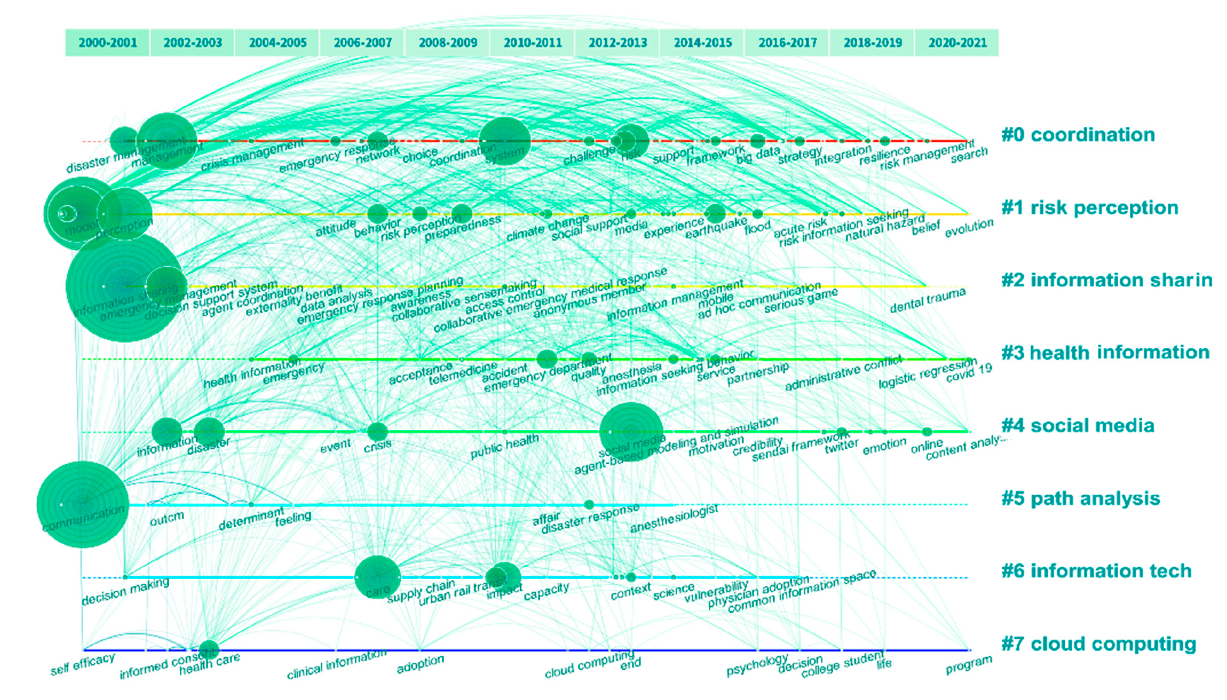
Figure 7. Keyword timeline view of publications on information communication in disasters from 2000 to 2021. The size of the circle represents the importance of the keyword, the links represent the frequency of keyword co-occurrence.